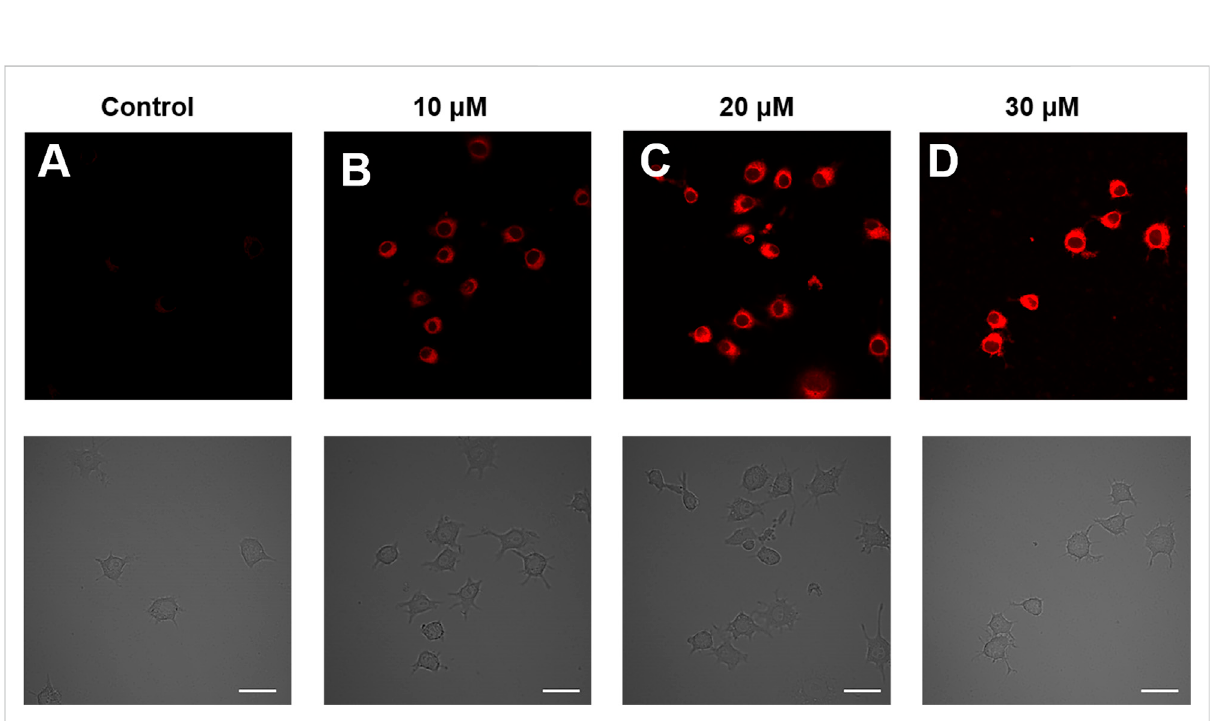
FIGURE 5 Imaging ofHClO inRAW 264.7cells using a confocal microscope with theHDCX-HClO probe (10 μ M). (A) RAW 264.7 cells serve as the control group.Beforeimagingthatisshownin (B – D) ,thecellswerepre-incubatedwithinhalfanhourconcerningHDCX-HClOandfollowedbytheaddition of HClO (10, 20, and 30 μ M) for 10 min in each of the three groups. Fluorescent images were recorded with excitation at 561 nm and emission at 690 – 770 nm. Scale bar = 20 μ